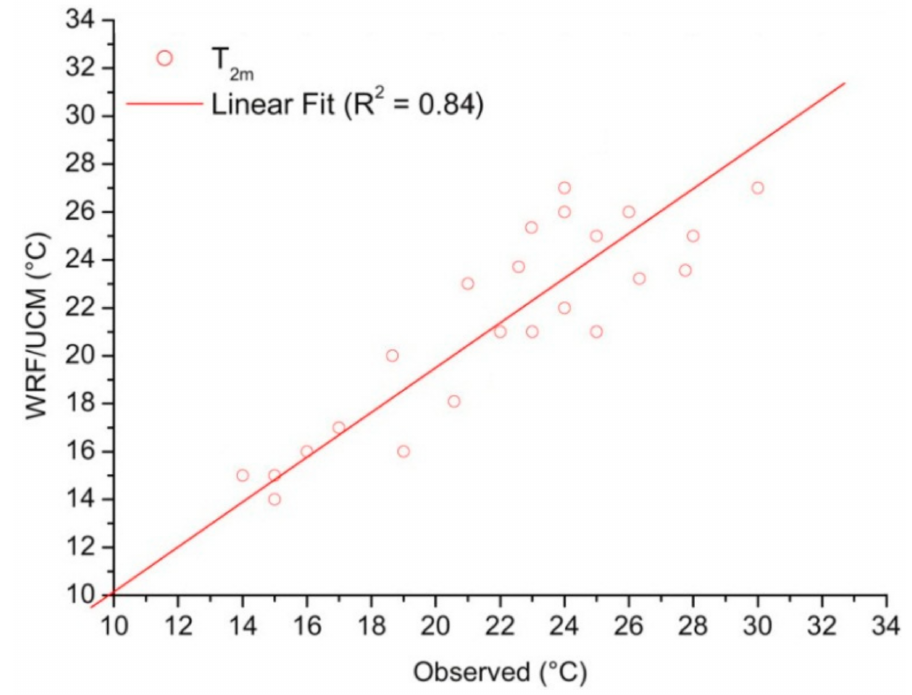
Figure 8. Observation and simulation scatter plot of air temperature at 2 m